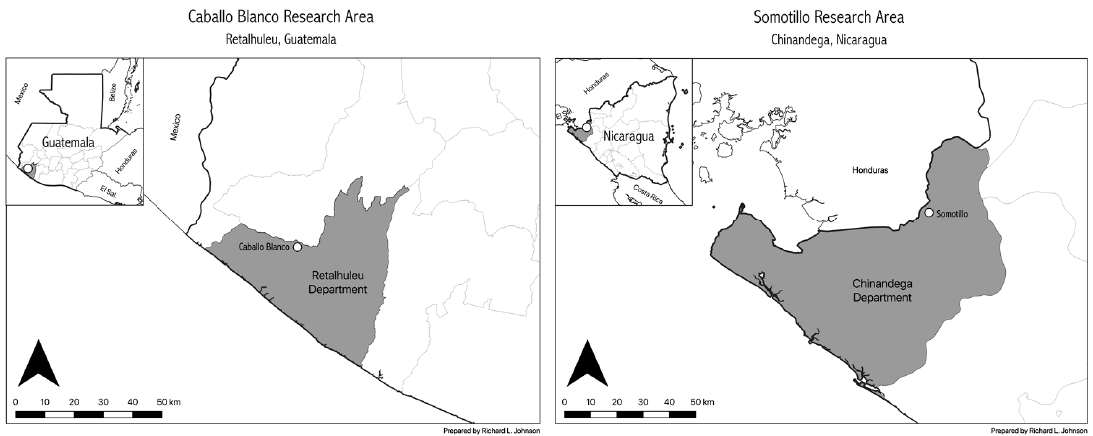
Figure 1. Study Figure 1. Study Sites.